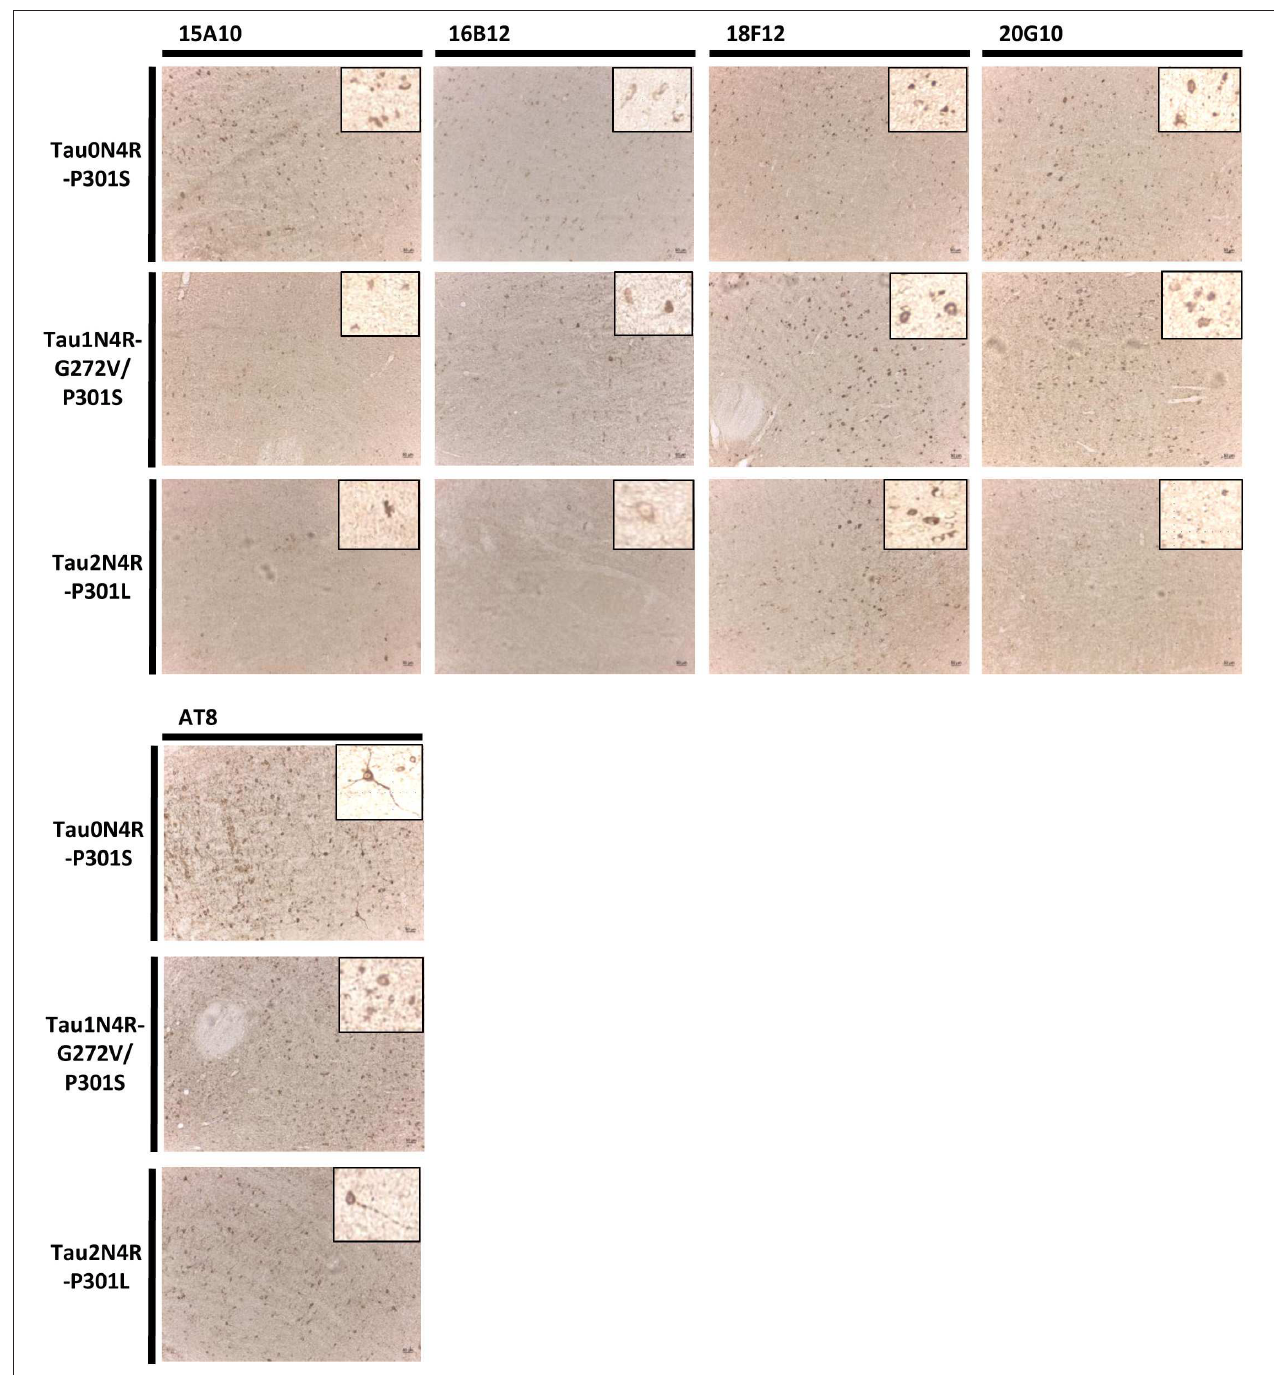
FIGURE 7 | Immunohistochemistry in transgenic mouse brain stem sections. Pictures represent immunohistochemical stainings performed using mAbs 15A10, 16B12, 18F12, and 20G10 on the brain stem of Tau0N4R-P301S, Tau1N4R-G272V/P301S, and Tau2N4R-P301L transgenic mice. AT8 was used as a reference antibody. A magnification of the tangle-like Tau pathology is also